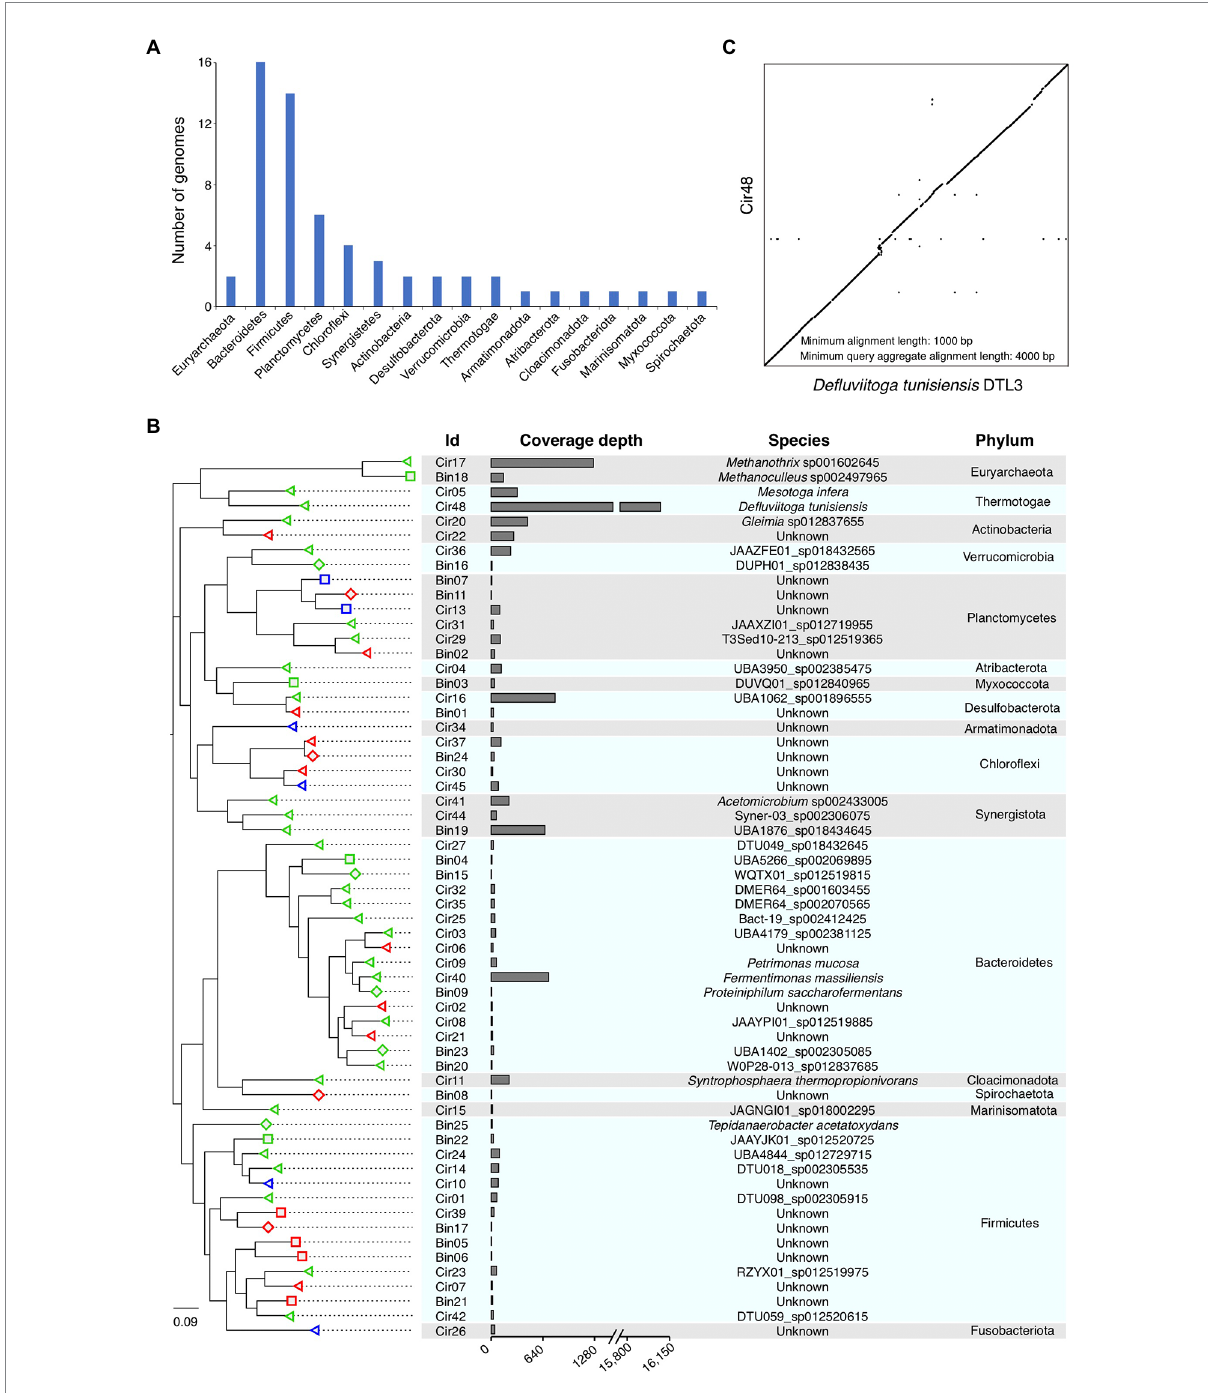
FIGURE 4 Phylogeny of the assembled microbial genomes. (A) Number of genomes belonged to different phyla . (B) Phylogenetic relationship of the assembled genomes. The phylogenetic tree was constructed using the 16S rRNA genes retrieved from all genomes, and the taxonomic annotation of the leaf nodes was performed using GTDB-Tk. The shapes of the leaf nodes correspond to the CheckM quality of the genomes, triangle represents “near-complete,” rectangle represents “high-quality,” and diamond represents “medium-quality.” The colors of the leaf nodes correspond to the taxonomic classification results of GTDB-Tk, “green” means the leaf node classified to be an existing species in the GTDB database, “red” and “blue” means the leaf node unclassified at species and genus level, respectively. Genome ids with prefix “Cir” represent circular genomes, and prefix “Bin” represents non-circular MAGs. (C) Pair-wise alignment of genome sequences between our genome Cir48 and the published Defluviitoga tunisiensis DTL3. The dot plot shows alignments longer than 1,000